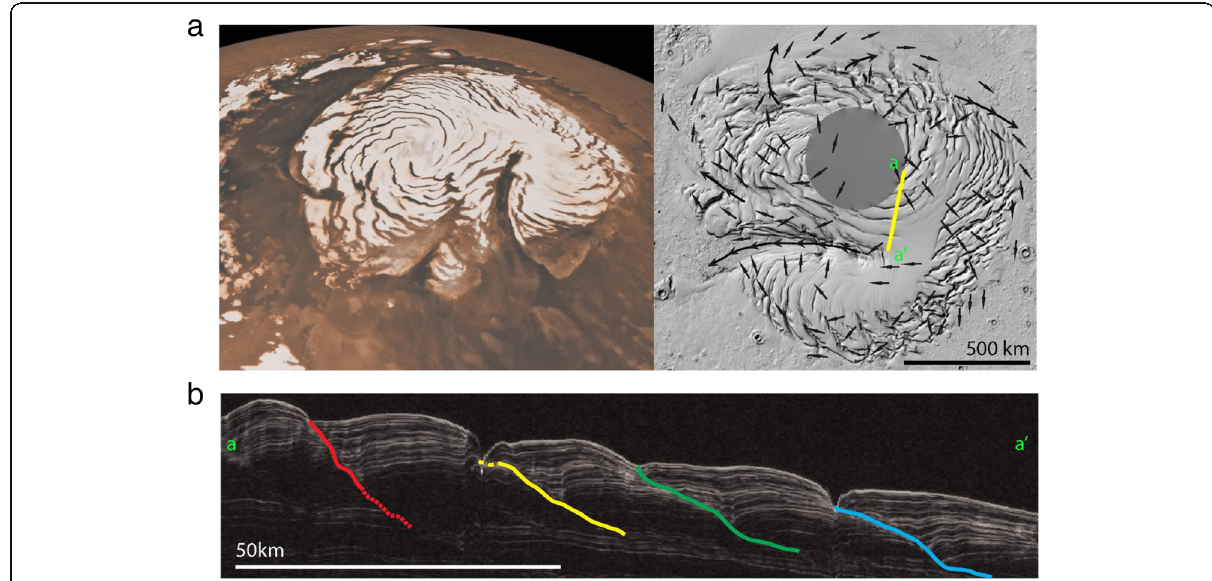
Fig. 7 Aeolian cyclic steps on the North Pole of Mars (modified from Smith et al. 2013). Shaded relief surface from MOLA elevation data demonstrates that a spiral troughs cover majority of the polar cap (left) and display a recognizable spiraling pattern due to the direction of katabatic winds working together with the Coriolis force (right). SHARAD profile a-a ’ shows b stratigraphy associated with spiral trough